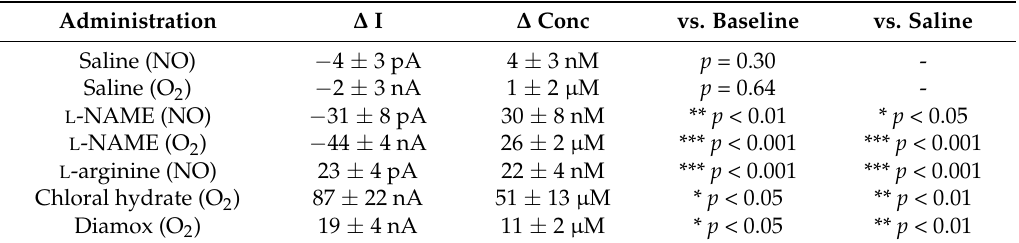
Table 1. Summary of in vivo characterization data for NO and O 2 sensors implanted in the striatum of freely moving NOD SCID mice ( n = 5). * denotes level of